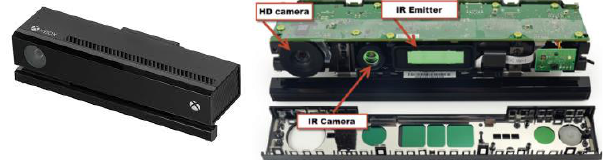
Fig. 2. The Kinect for Xbox One (Kinect v2) sensor.